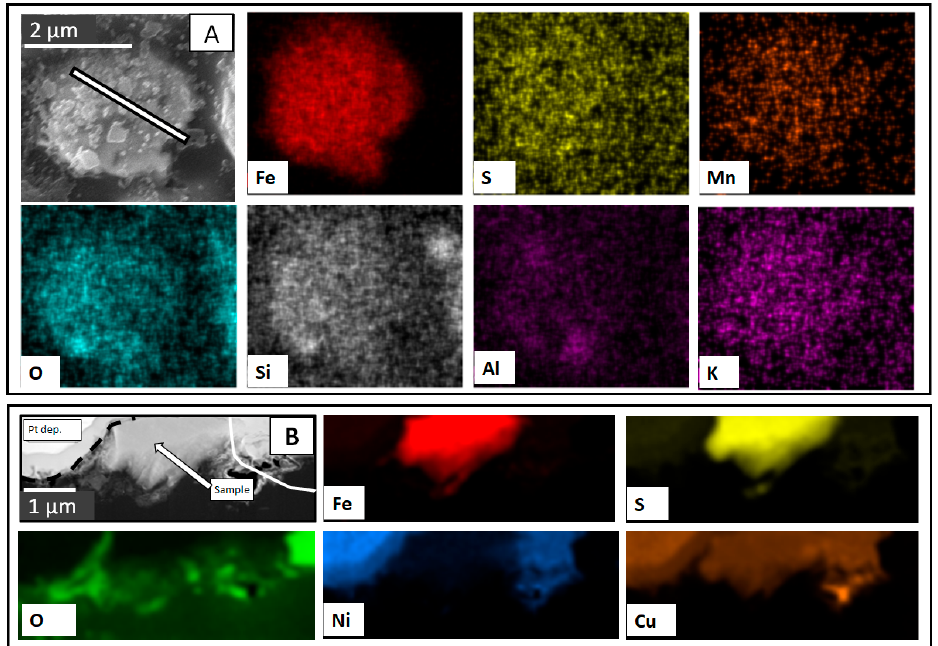
Figure 6. ( A ) SEM image and EDS element maps of a representative colloid soils developing on historic coal mine spoil; the white line represents the site of FIB section extraction; ( B ) TEM image of the extracted FIB section with EDS element maps. The dashed line represents the boundary be ‐ tween the FIB section and the Pt, and the white line represents the contact between targeted colloid and surrounding material. The grain was identified as anorthite based on the ( − 1, − 7,1) reflection with a d ‐ spacing of 1.7813 Å.